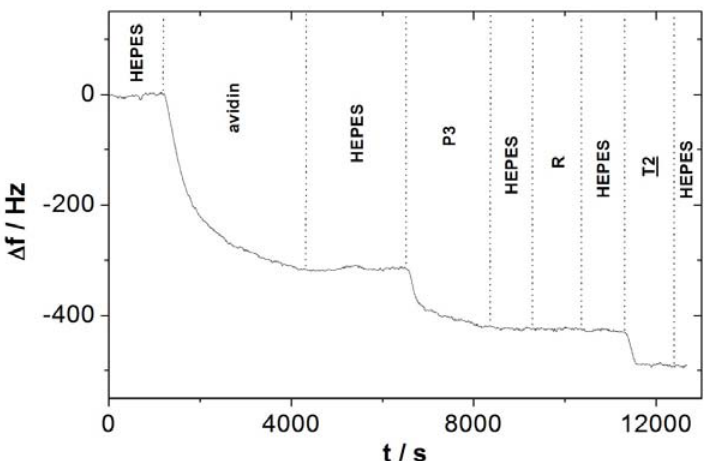
Figure 5. Microbalance frequency changes during avidin grafting, biotin-labeled probe (P3) grafting and selective complementary target (T2)